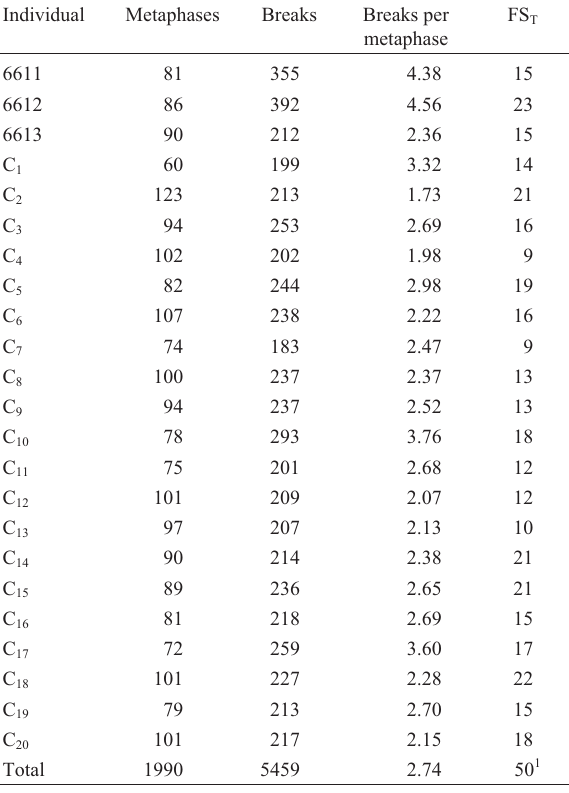
Table I - Chromosomal-breakage data from APC-treated metaphases obtained for the three translocation-carrying subjects (6611, 6612, and 6613) and for each of the 20 (C 1 - C 20 ) karyotypically-normal control individuals. FS T is the total number of sites identified as fragile in that individual.